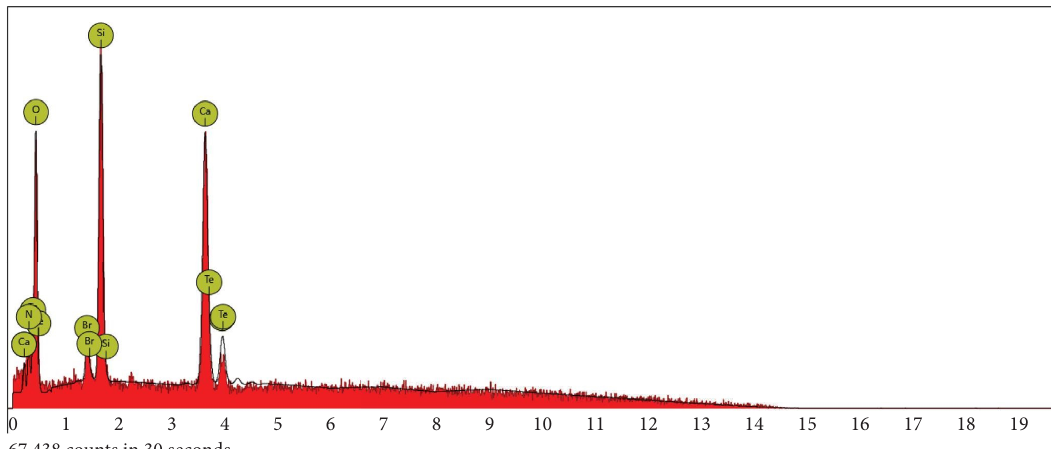
Figure 30: Element distribution in M2 sample at room temperature.